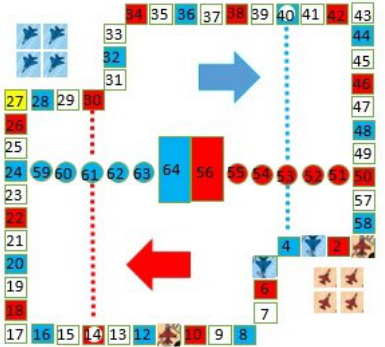
Figure 3. An example with chess position ( S , R ) , where S = ( 3,5,0,0,1,11,0,0 ) and R = 3.